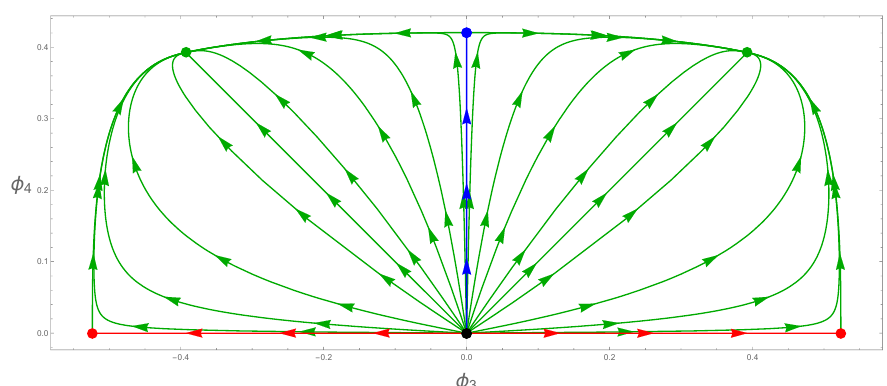
Figure 4 . Parametric plots for the RG flows in the SU(2) invariant 5-scalar truncation. The black dot is the AdS 5 vacuum, the red dots are two LS AdS 5 solutions, the green dots are two N = 2 , SU(2) × U(1) invariant AdS 4 × R S-fold solutions, while the blue dot is the N = 1 , SU(3) invariant AdS 4 × S 1 S-fold solution. The generic RG flows, denoted by green lines, move from the AdS 5 vacuum in the UV to the N = 2 S-fold solution in the IR and there are a number of interesting limiting solutions. The green line with φ 3 = − φ 4 is the N = 2 RG flow considered in section 5.2, the blue line with φ 3 = 0 is the N = 1 RG flow considered in section 5.3 and the red lines are the homogeneous RG flows from the AdS 5 vacuum to the LS fixed